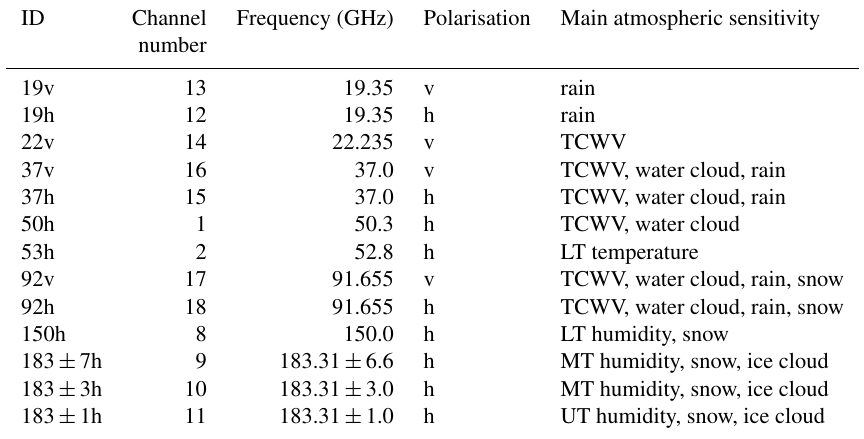
Table 1. SSMIS channels used in this study, ordered by frequency and polarisation. ID Channel Frequency (GHz) Polarisation Main atmospheric sensitivity number 19v 13 19.35 v rain 19h 12 19.35 h rain 22v 14 22.235 v TCWV 37v 16 37.0 v TCWV, water cloud, rain 37h 15 37.0 h TCWV, water cloud, rain 50h 1 50.3 h TCWV, water cloud 53h 2 52.8 h LT temperature 92v 17 91.655 v TCWV, water cloud, rain, snow 92h 18 91.655 h TCWV, water cloud, rain, snow 150h 8 150.0 h LT humidity, snow 183 ± 7h 9 183.31 ± 6.6 h MT humidity, snow, ice cloud 183 ± 3h 10 183.31 ± 3.0 h MT humidity, snow, ice cloud 183 ± 1h 11 183.31 ± 1.0 h UT humidity, snow, ice